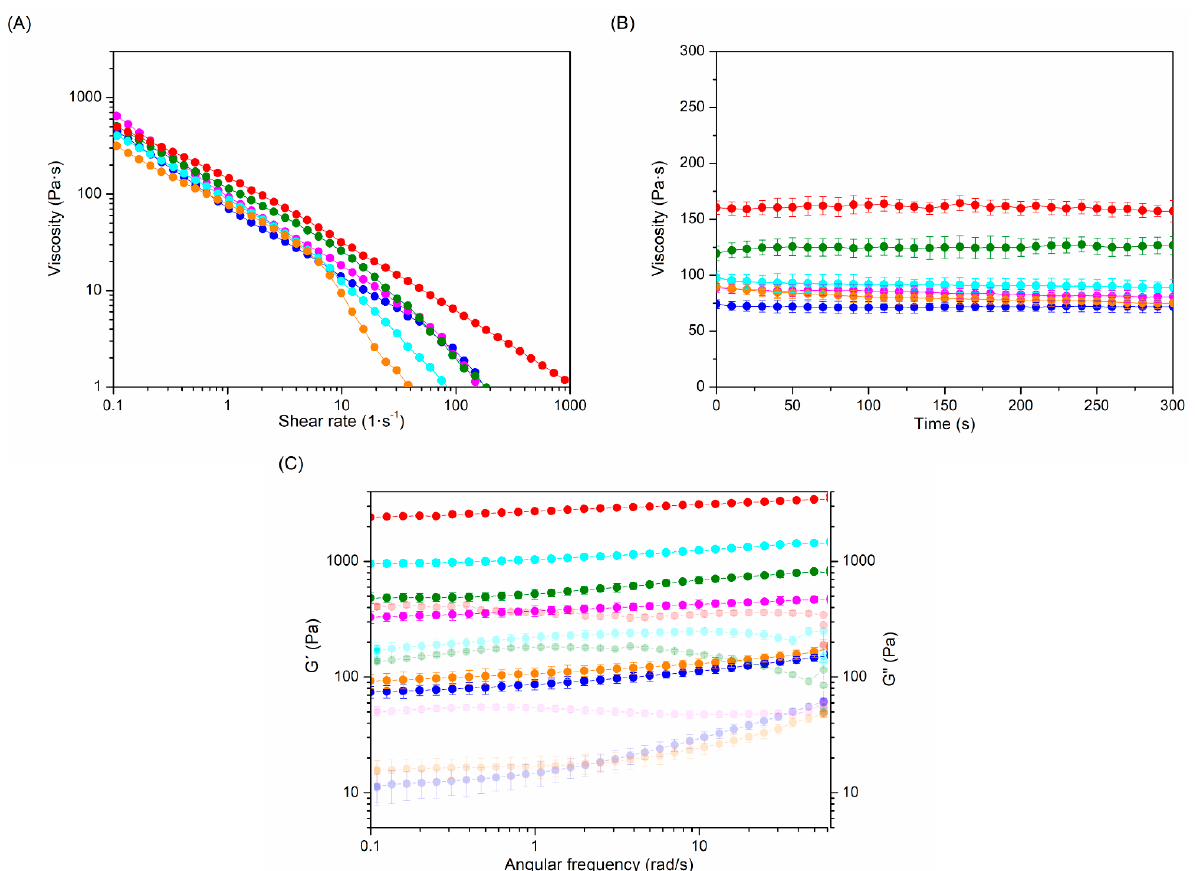
Figure 2. ( A ) Shear rate, ( B ) time, and ( C ) frequency sweeps for viscosity, elastic (G ′ ) and viscous (G ′′ ) moduli determination of HA-BDDE samples. HA-BDDE-1 ( ● ), HA-BDDE-2 ( ● ), HA-BDDE-3 ( ● ), HA-BDDE-4 ( ● ), HA-BDDE-5 ( ● ) and HA-BDDE-6 ( ● ). H C protons (1.60 ppm) and methyl protons of the N-acetyl groups (1.90 ppm)